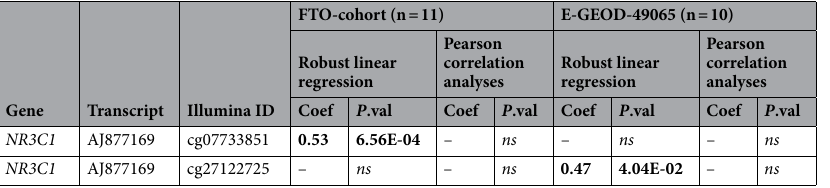
Table 2. Methylation/transcription correlations of HPA-axis associated CpG sites differentially methylated by DST non-suppression status and positively correlated with DST cortisol levels. The table lists CpG-sites located within the TSS2000 of HPA-axis genes with significant cortisol post DST-associated methylation changes. These methylation probes are investigated for a correlation with transcription in two separate cohorts with healthy controls (FTO-cohort and E-GEOD-49065 cohort). Methylation M-values were correlated with expression values inter-individually, by pearson correlations and robust linear regression models, respectively. Coef . regression coefficient; P .val, P